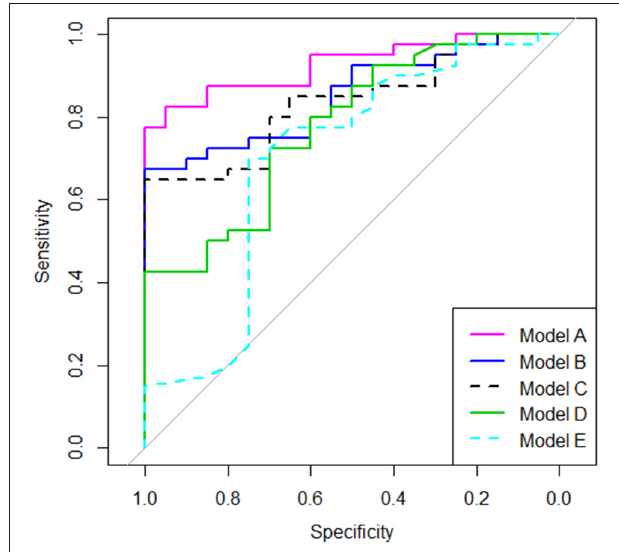
FIGURE 2 | Comparing discriminative information using ROC